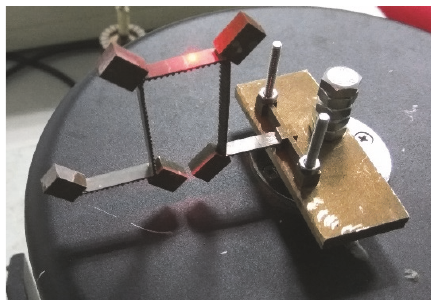
Figure 8: Prototype of the energy harvester.